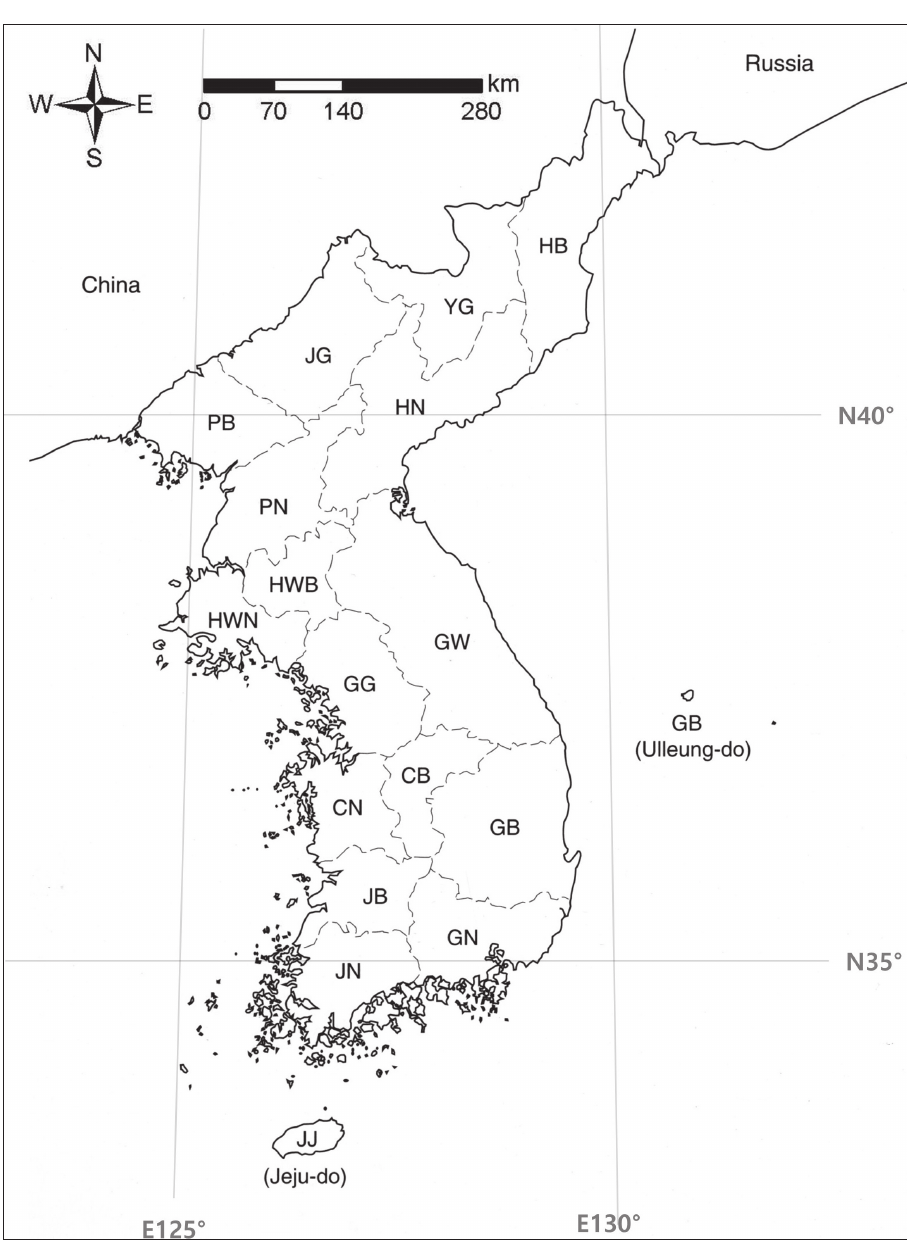
Figure 1. The regionalization (provinces) of the Korean Peninsula accepted in the present paper. Abbre- viations: CB Chungcheongbuk-do CN Chungcheongnam-do GB Gyeongsangbuk-do GN Gyeongsang- nam-do GG Gyeonggi-do GW Gangwon-do HB Hamgyeongbuk-do HN Hamgyeongnam-do HWN Hwanghaenam-do HWB Hwanghaebuk-do JB Jeollabuk-do JG Jagang-do JN Jeollanam-do JJ Jeju-do PB Pyeonganbuk-do PN Pyeongannam-do YG